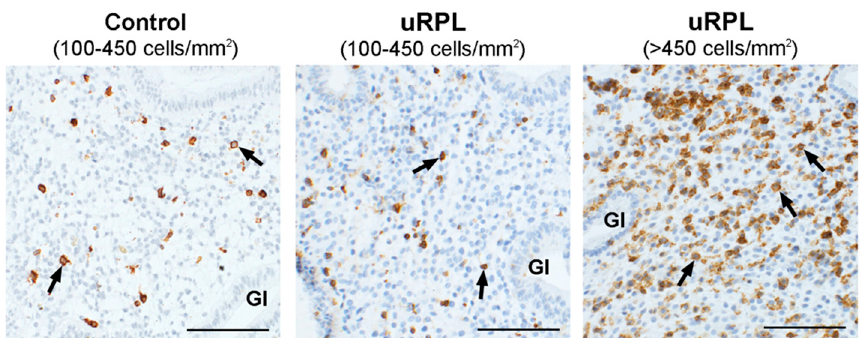
Figure 1. Immunohistochemical localization of CD45 + cells (arrows) in the endometrium of the control and unexplained recurrent pregnancy loss (uRPL) groups (100–450 cells / mm 2 ) and of uRPL patients (100–450 and > 450 cells / mm 2 ). Gl: endometrial glands. Scale bar = 100 µ m.